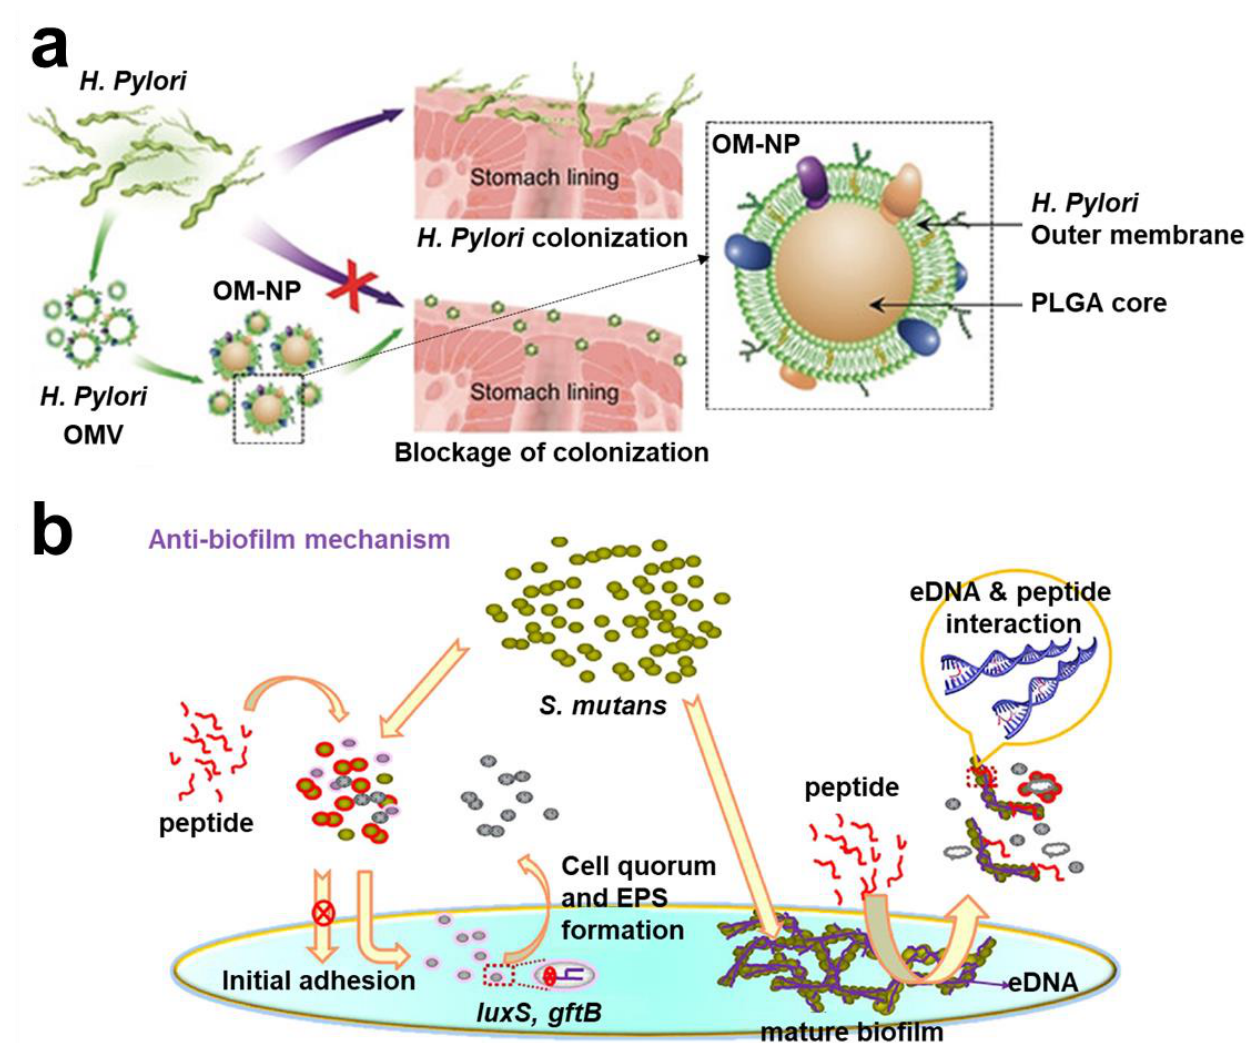
Figure 3. Schematic diagram of interfering with bacterial adhesion strategies. ( a ) OM-NPs coated with outer membrane of H. pylori , which could compete with bacteria for binding sites on cells. Reprinted with permission from Ref. [86]. Copyright 2012, Prof. Dr. Anke Kruege. ( b ) G3 inhibited bacterial adhesion and interfered with biofilm formation. Reprinted with permission from Ref. [89].